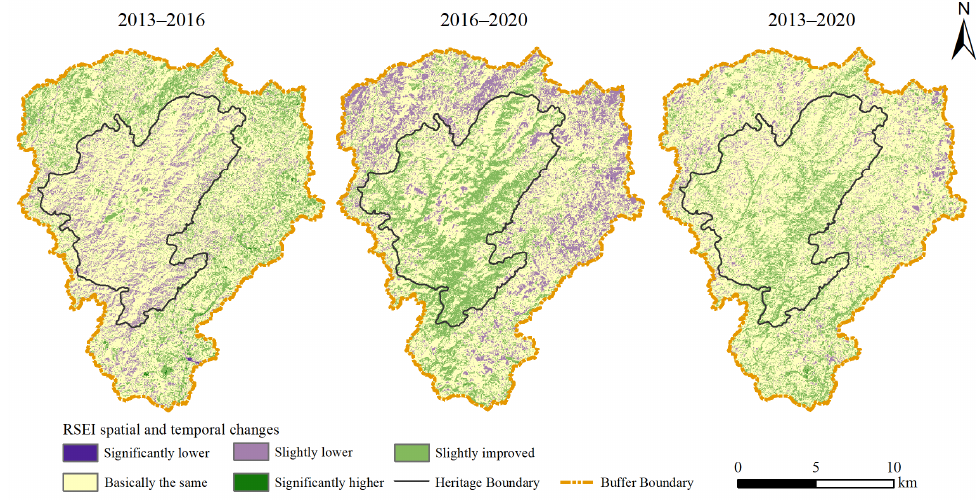
Figure 5. Analysis of RSEI changes from 2013 to 2020.